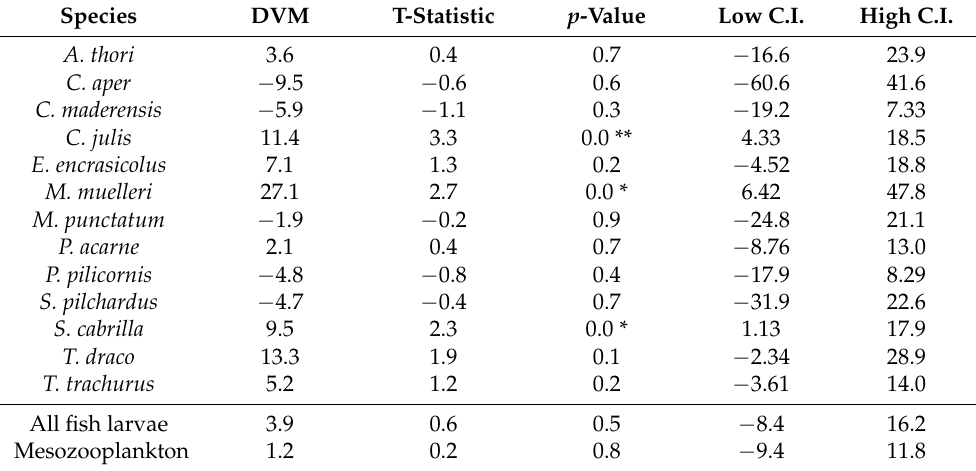
Table 5. Results of the day and night weighted mean depth analysis and respective t -test analysis. The data show the diel vertical migration (DVM) of the dominant species. Positive DVM indicates species ascending at night and descending during the day (DVM type I). Negative DVM indicates species descending at night and ascending during the day (DVM type II). The ** stands for p < 0.01 and * < 0.1. Species DVM T-Statistic p -Value Low C.I. High